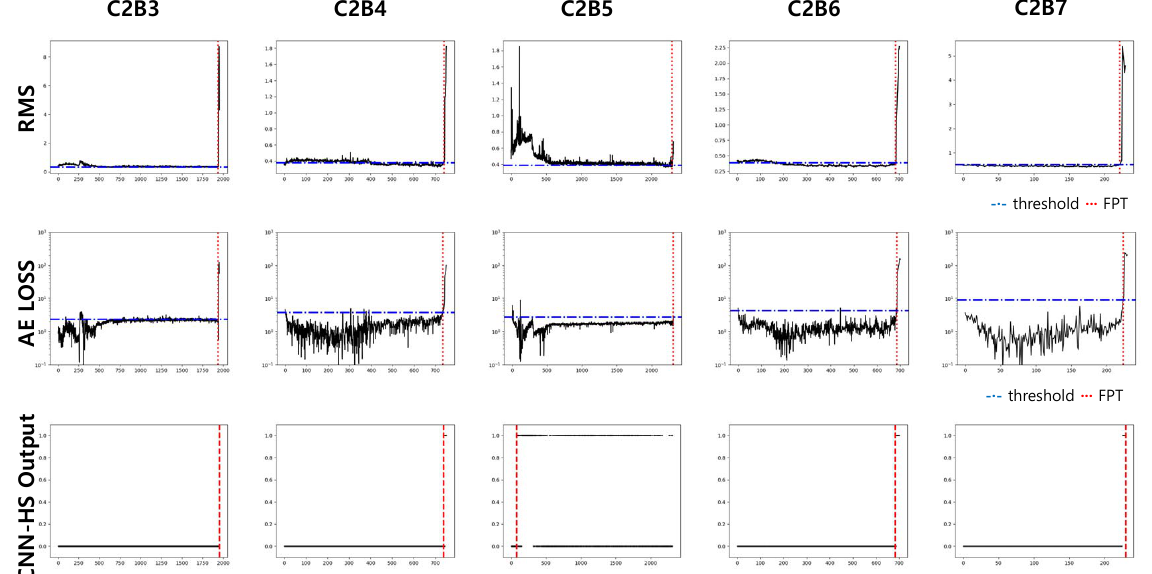
Figure 10. Predicted FPT using RMS, AE, and CNN-HS on FEMTO dataset (condition